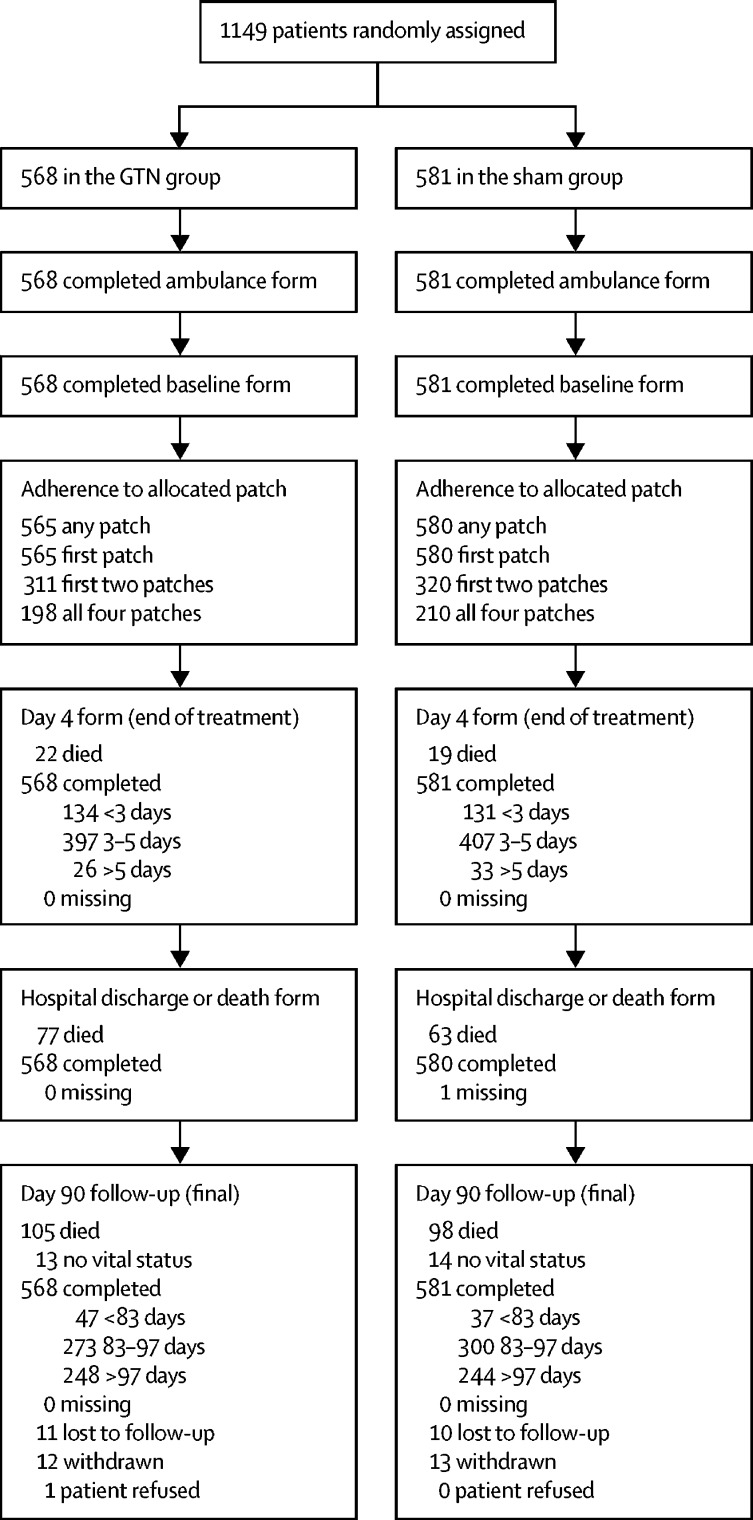
Trial profile for cohort 2Cohort 2 includes all patients (intention-to-treat population). GTN=glyceryl trinitrate.